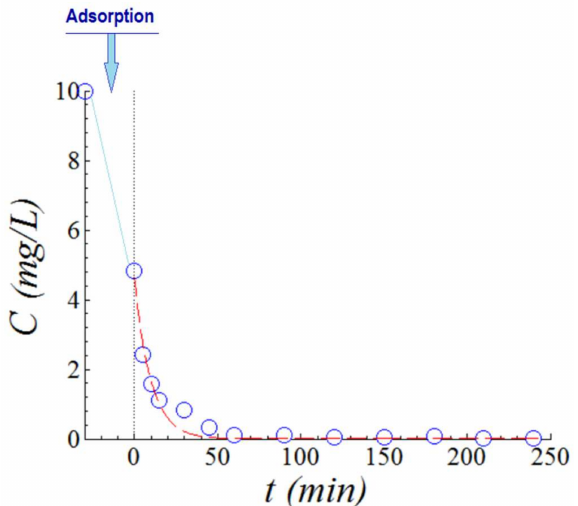
Figure 11. Kinetics of photocatalytic degradation (UV-Vis light) of EB dye recorded under optimal conditions in the presence of ZnAlFe 0.94 Sm 0.06 O 4 (sample ZFASm0.06); experimental conditions: CatDose = 0.765 g/L, (H 2 O 2 ) = 0.077 M, and T = 25 ± 1 ◦